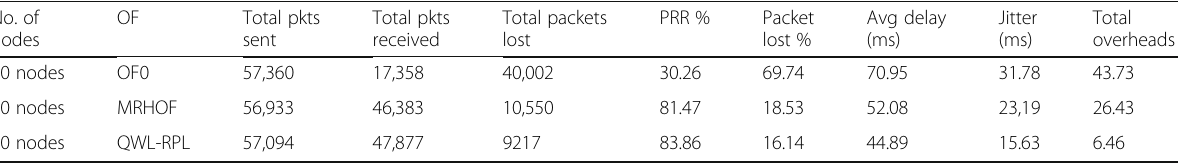
Table 10 Analysis of Tmote Sky mote No. of